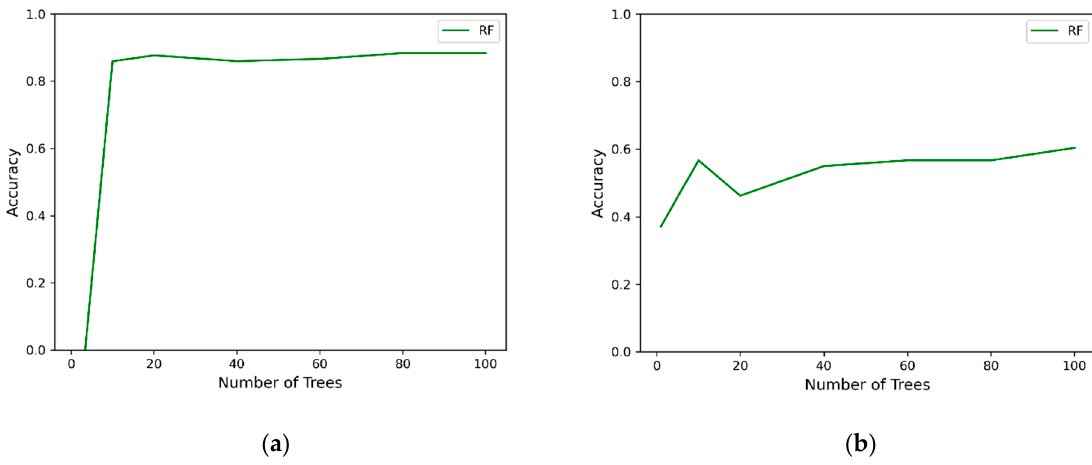
Figure 9. Random Forest classification accuracy vs. the number of trees for ( a ) plastic viscosity and ( b ) apparent viscosity.